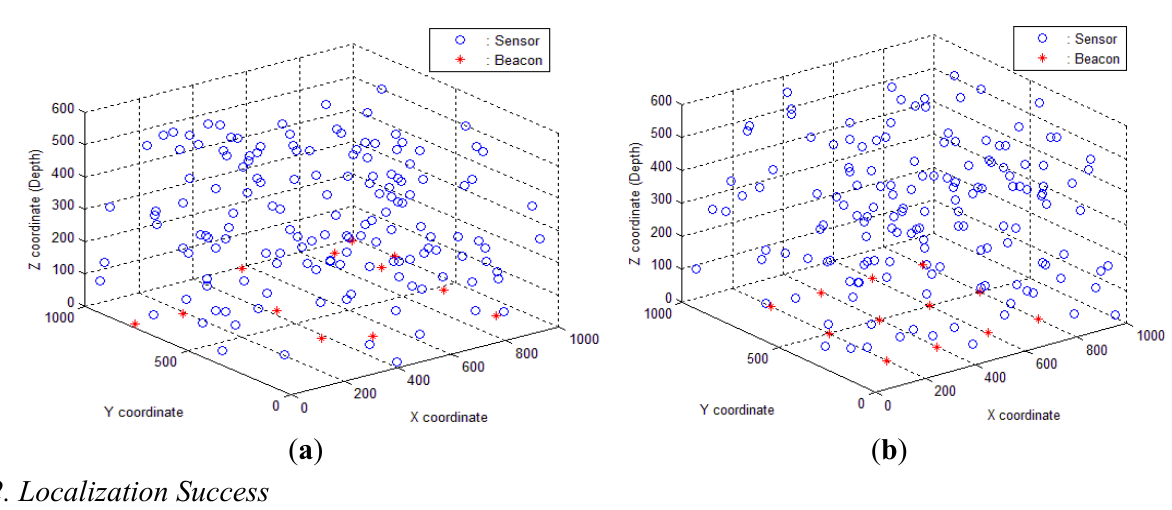
Figure 6. ( a ) Random distribution; ( b ) Grid anchor deployment.